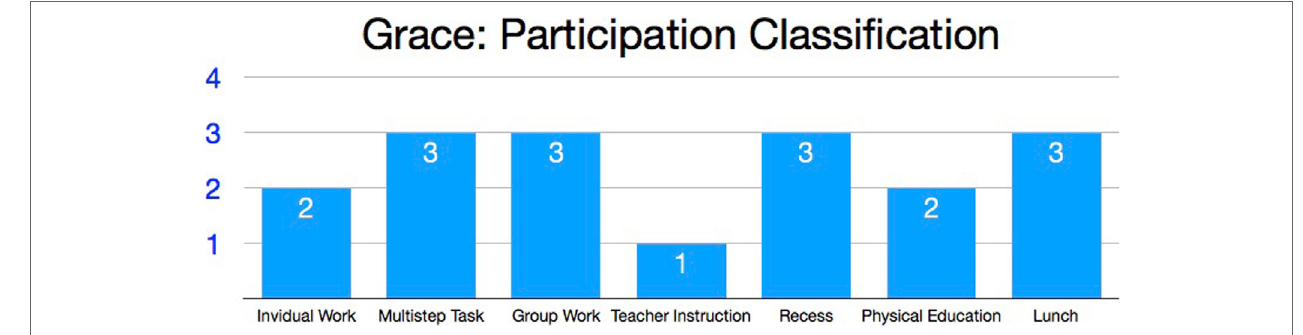
FigUre 3 | “Grace”: classification of participation levels for activities in the school environment.